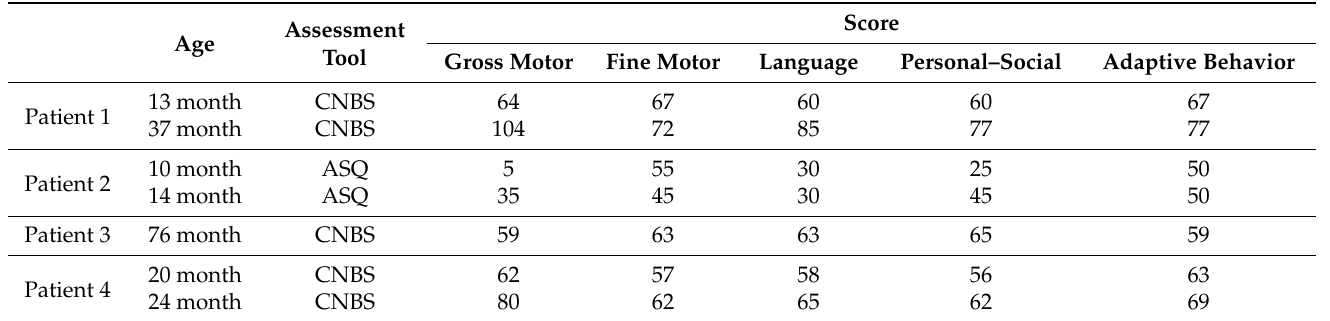
Table 2. Neurodevelopmental scores of patients with NAA15